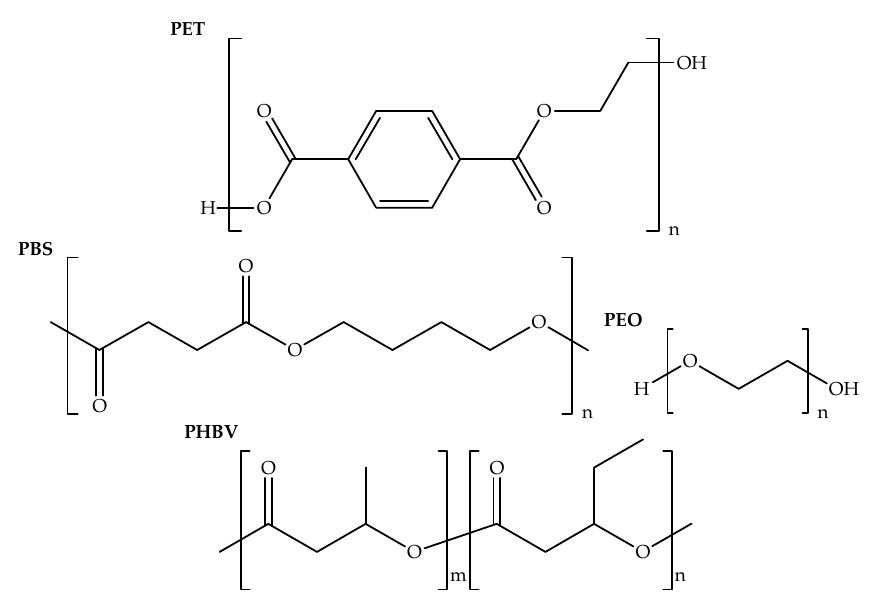
Figure 2. Chemical structures of thermoplastic polymers and the abbreviations are explained in Table 1.